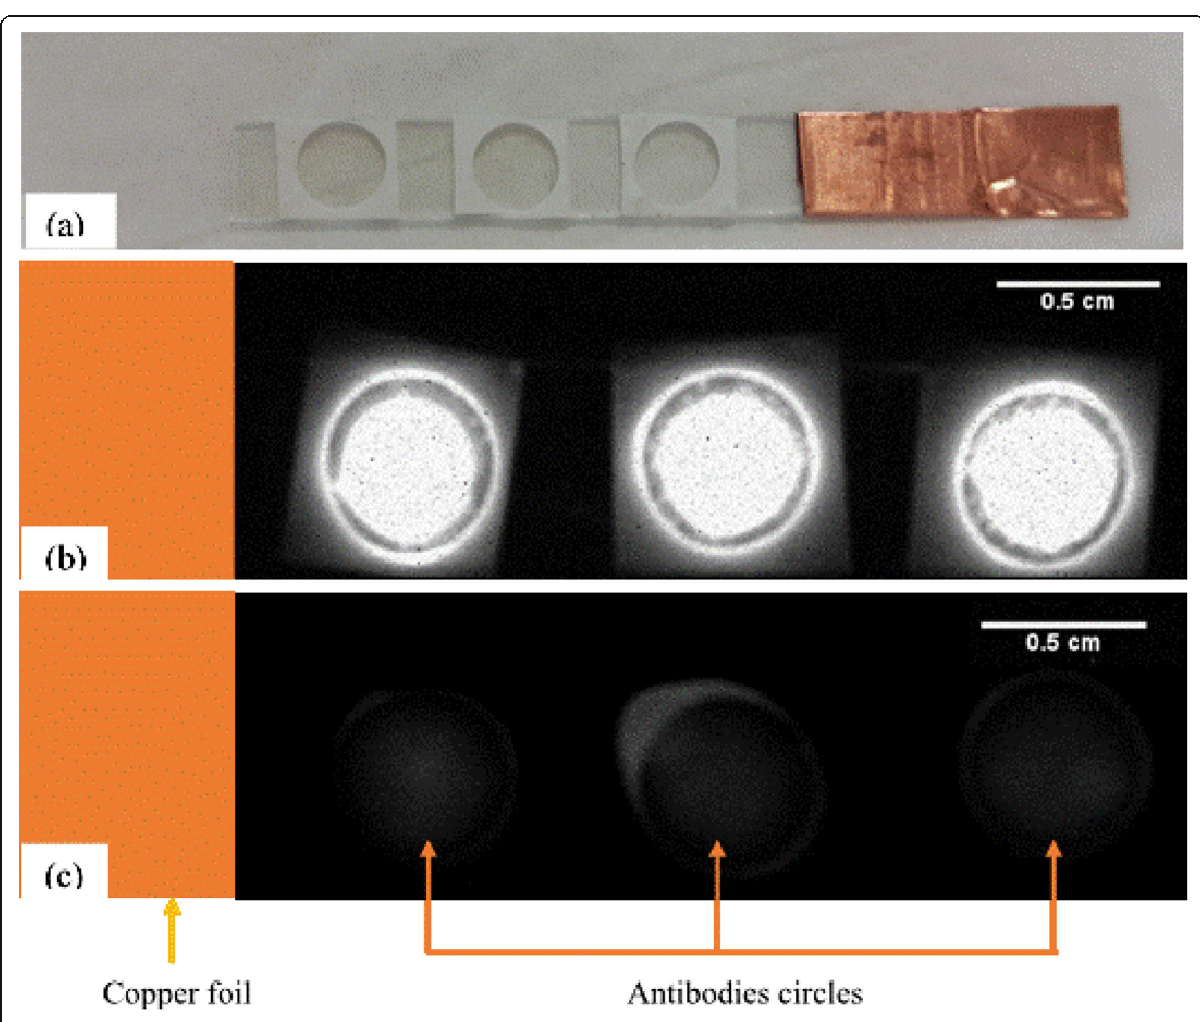
Fig. 3 a Image of an ITO electrode taken with the digital camera showing the three separated circle containing immobilized ferrocene tagged anti-cortisol antibody, b images of blank after the addition of luminol/hydrogen peroxide mixture, c CL image of the blank after the incubation of 50 ng ml − 1 cortisol hormone. Scale bar for image A is 5 cm, and B and C are 0.5